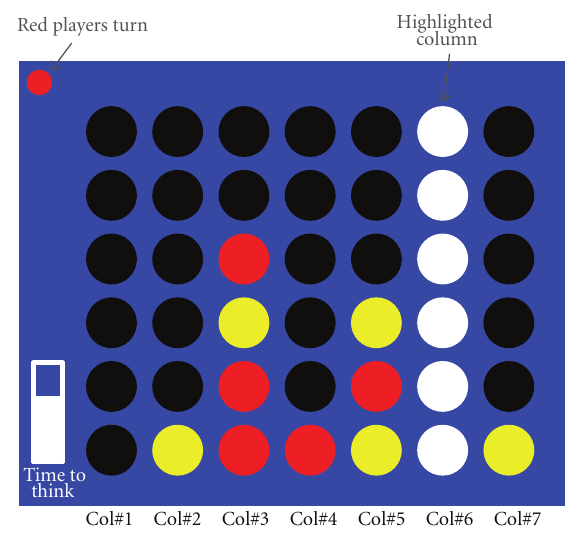
Figure 2: P300-based BCI “Connect Four”. Black disks represent the empty places. Yellow and red disks correspond to player P1 and player P2 pieces, respectively. The column made of white disks represents a flashed